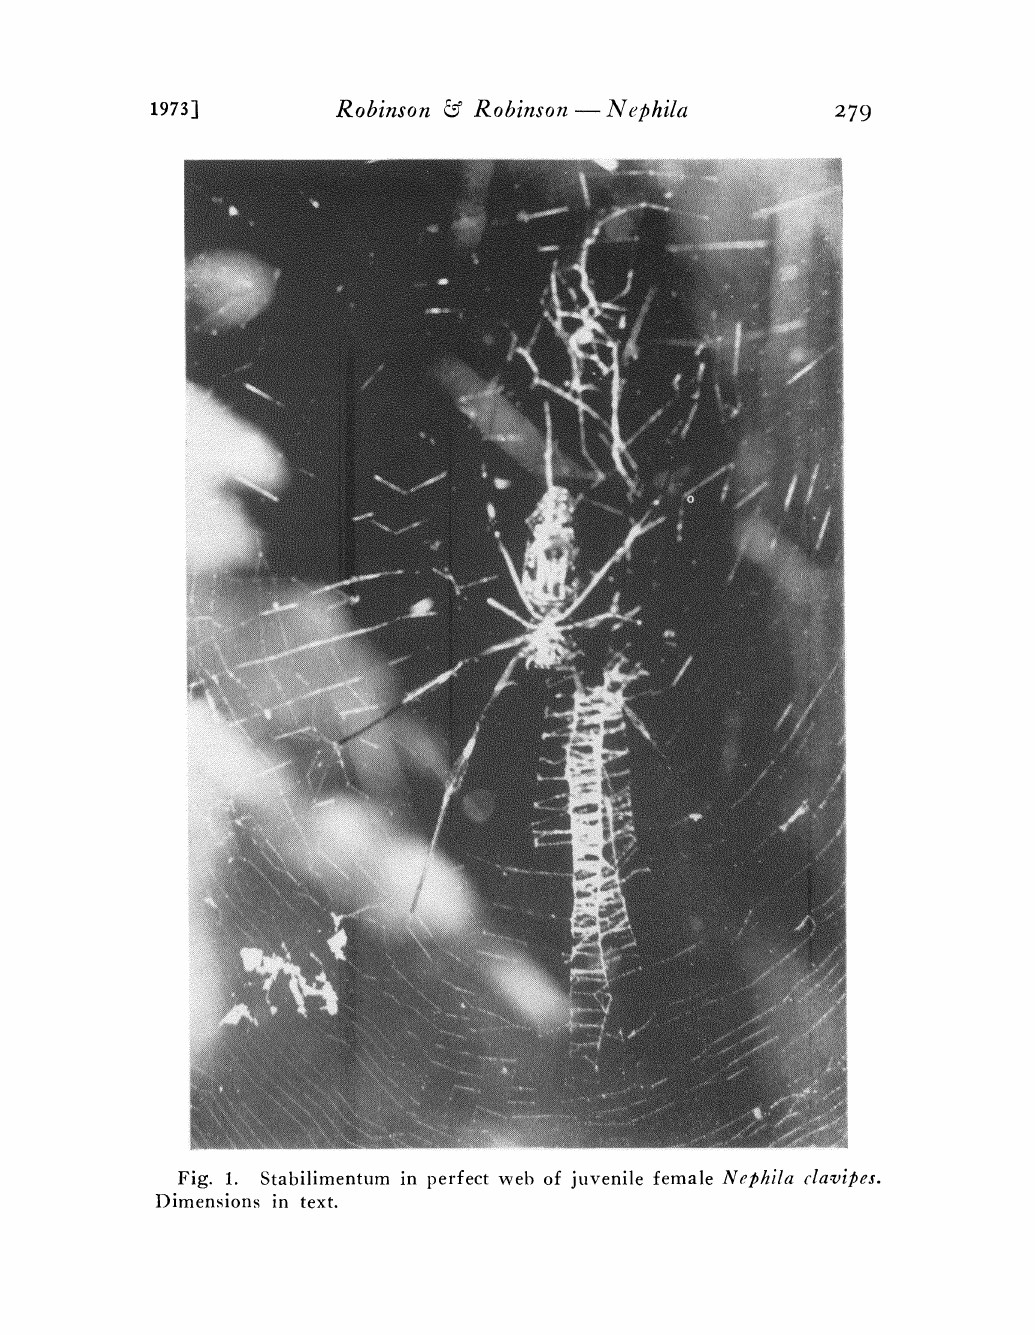
Fig. 1. Stabilimentum in perfect web of juvenile female Nephila cla.vipes. Dimensions in